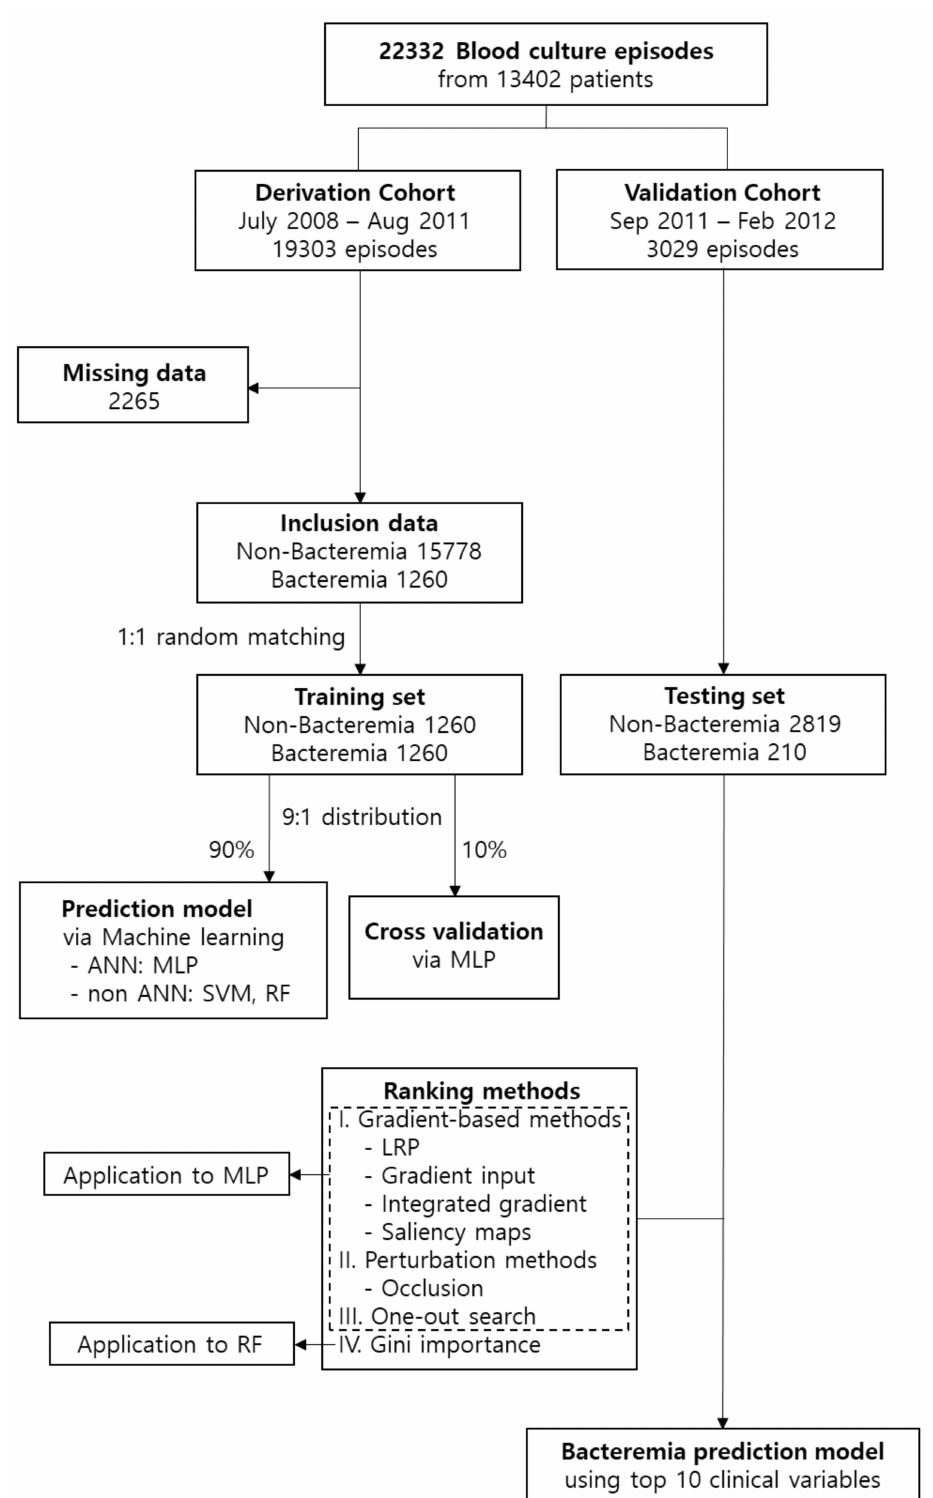
Figure 1. Flow chart of the study design and analysis. ANN: artificial neural network; LRP, layer-wise relevance propagation; MLP, multi-layer perceptron; RF, random forest; and SVM, support vector